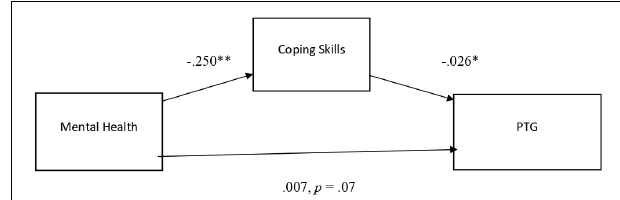
FIGURE 1 | Standardized regression coefficients for the relationship between mental health as measured by GHQ and post-traumatic growth as mediated by coping